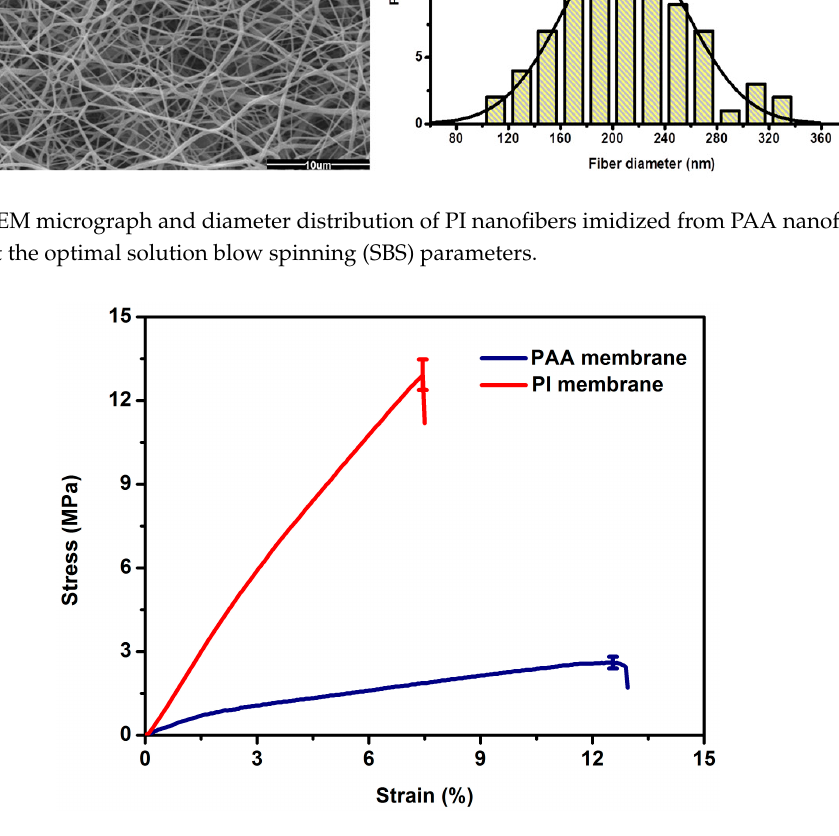
Figure 9. Tensile stress-strain curves of PAA and PI nanofiber membranes.